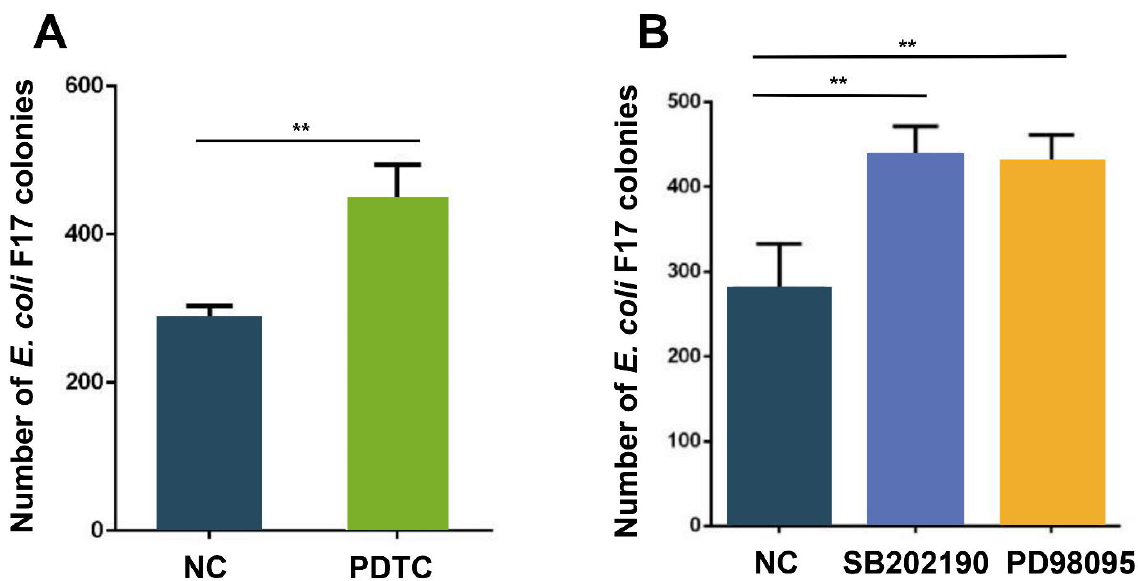
Figure 5. The effect of NF- κ B and MAPK pathways on the adhesion of E. coli F17 to OIECs. ( A ) Adhesion of the F17 fimbria to OIECs treated with NF- κ B inhibitor PDTC compared with negative control analyzed by bacteria enumeration. ( B ) Adhesion of the F17 fimbria to OIECs treated with p38 MAPK inhibitor SB202190 and ERK1/2 MAPK inhibitor PD98095 compared with negative control analyzed by bacteria enumeration. ** p < 0.01, extremely significant difference; data were shown as mean ± SD, n = 3 biological replicates.